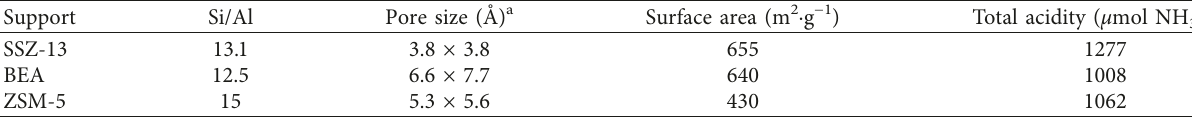
Table 1: Physical characterization of support materials.